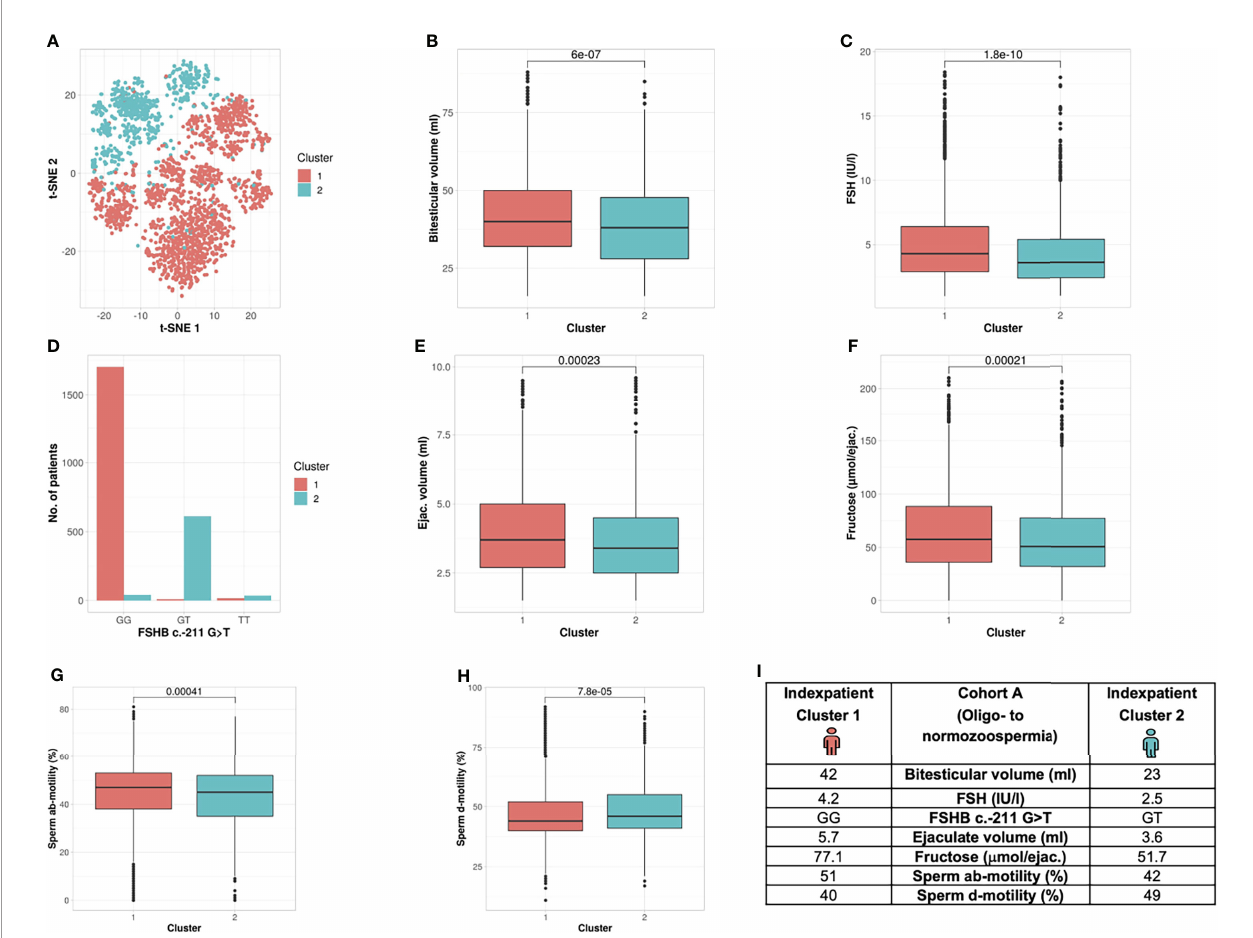
FIGURE 3 | Cluster analysis Cohort A: Identi fi cation of two clusters and seven segregation parameters (oligo- to normozoospermia). (A) Distribution of patients in the clusters. Each dot represents one patient of the entire cohort (n=2422). The distances between the patients are presented in two-dimensional space. Silhouette width is 0.12. (B – H) The andrologic parameters bi-testicular volume, FSH and FSHB c.-211, ejaculate volume, fructose, ab- and d-motility are the signi fi cant segregation markers between the two clusters. The boxes show the fi rst, second (i.e., median) and third quartiles of the respective parameters in Cluster 1 (comprising most individuals with GG) and Cluster 2 (comprising most individuals with a T allele). Outliers are shown as circles above the whiskers. The patients in the clusters differ signi fi cantly in regard to the mentioned seven andrologic parameters. Adjusted p values are located in the plots and range from (p < 2.2e -16 to 0.00023). (I) Reproductive parameters of the index patient of Cluster 1 and 2. The index patient represents Cluster 1 or 2, respectively, with the parameters in which both clusters differ signi fi cantly. (The presented values do not necessarily match the median or mean of all parameters in the